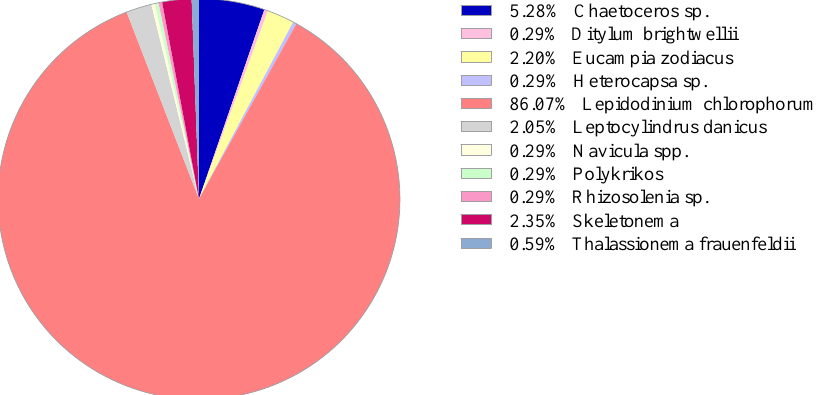
Figure 8. Microscopic phytoplankton identification and quantification by microscope: The water sample was collected from Metri, Chile (−41°5967′, −72°7056′) on 24 April 2019, from 0–10 m depth. A total of 682 phytoplankton cells were detected. Lepidodinium chlorophorum was the dominant species.